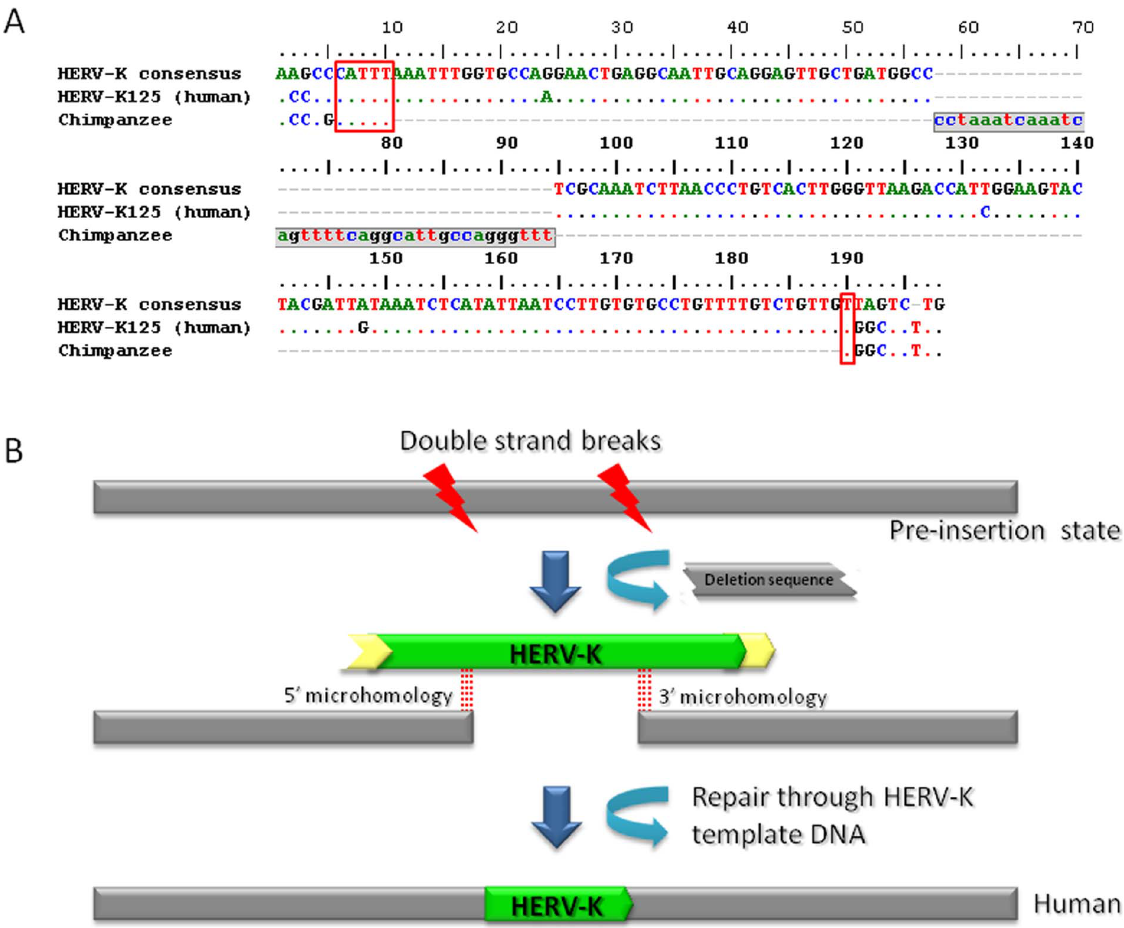
Figure 5. Non-classical insertion of human-specific HERV-K element in the human genome. Four non-classical insertions of human- specific HERV-K were observed in the human genome. The human-specific locus, HERV-K125, is depicted here. (A) An alignment of the non-classical insertion of human-specific HERV-K125 element, and its pre-insertion site to the HERV-K consensus sequence. This alignment reveals a 37 bp deletion of the pre-insertion site in the human genome (gray region in the chimpanzee sequence). Red boxes indicate microhomology at either end of the non-classical insertion, which suggests the involvement of an NHEJ mechanism. (B) A schematic diagram that describes the non-classical insertion of an HERV-K element (green box) and the deleted-region of genomic sequence (broken gray box).